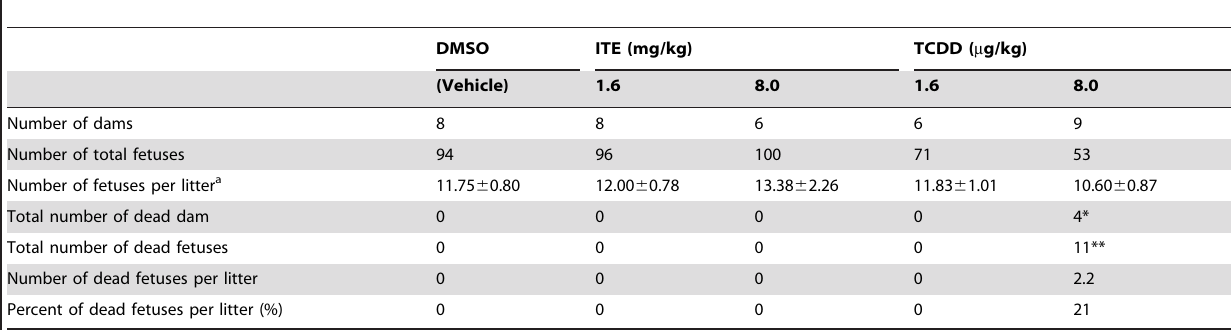
Table 2. Effect of GD15 ITE/TCDD exposure on reproductive outcomes on GD20.